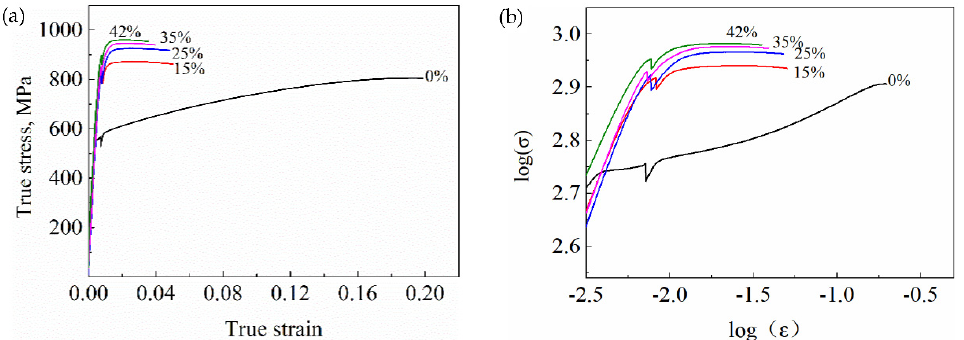
Figure 7. True-sress–true-strain curves of Gr.4 strip: ( a ) true-stress–true-strain curves, ( b ) log–log scale true-stress–true-strain curves.